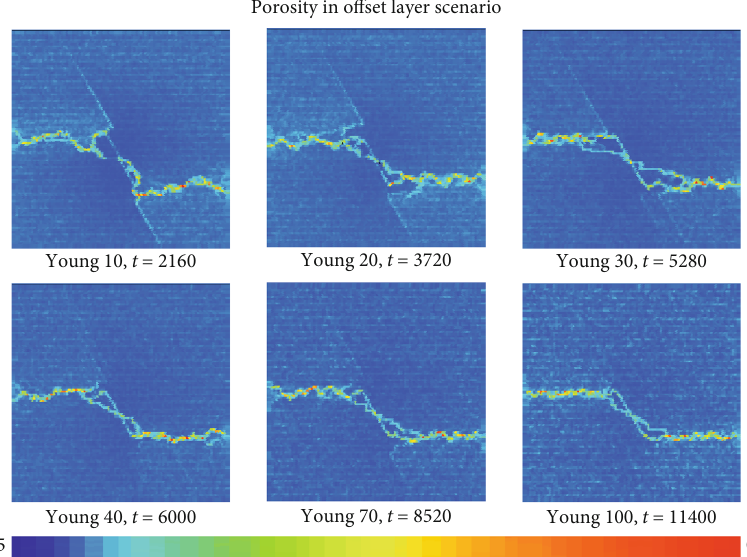
Figure 8: The fi nal porosity pattern for 6 faulted horizontal layers with di ff erent Young ’ s moduli. Young ’ s modulus is in GPa, and time t is in hours. The developing patterns are quite similar for di ff erent Young ’ s moduli, and they all connect across the fault and have a semihorizontal orientation. All simulations show a compacted zone in the hanging and the footwall of the fault. The softer layers (Young ’ s modulus below 40GPa) show high porosity within the fault that extends into the host